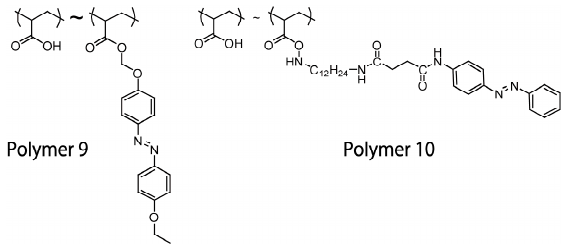
Figure 11. Chemical structures of Polymers 9 and 10 .